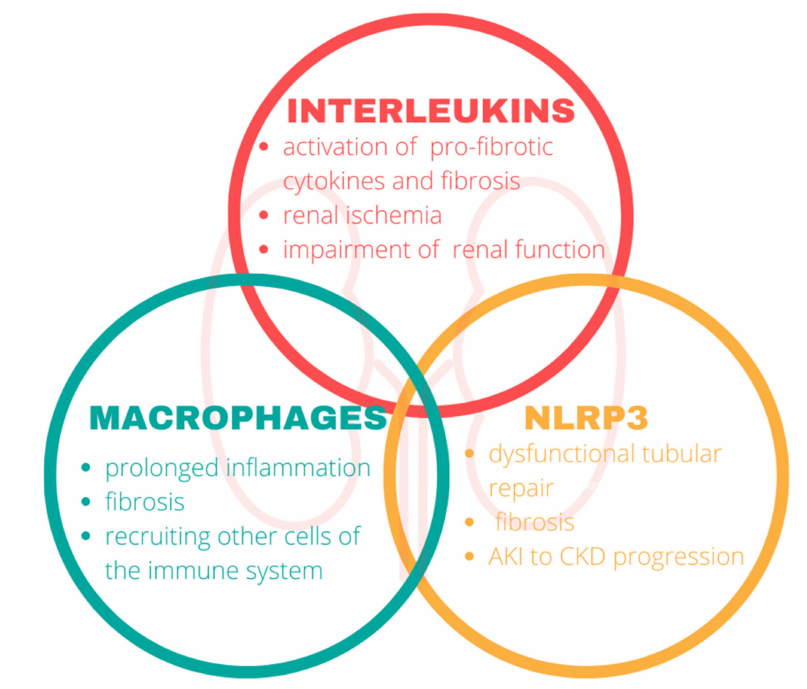
Figure 2. The impact of the immune system on the kidneys. Components of the immune system mediate the disruption of renal functions and play a central role in the progression of chronic kidney disease. NLRP3, nod-like-receptor protein